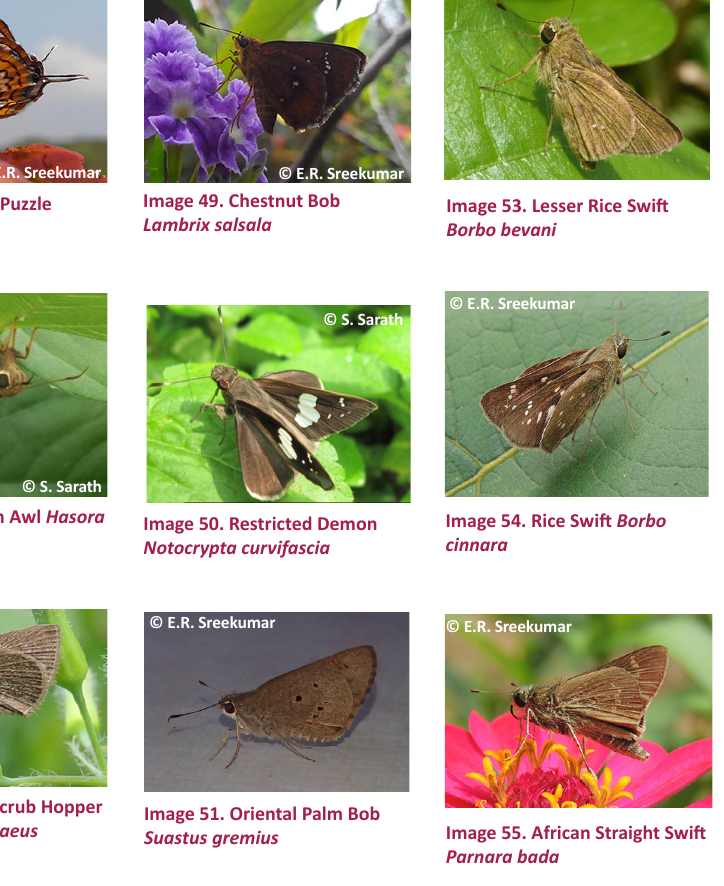
Image 55. African Straight Swift Parnara bada